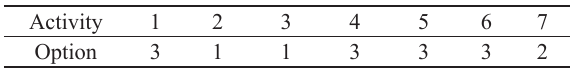
Table 3. Optimal solution options